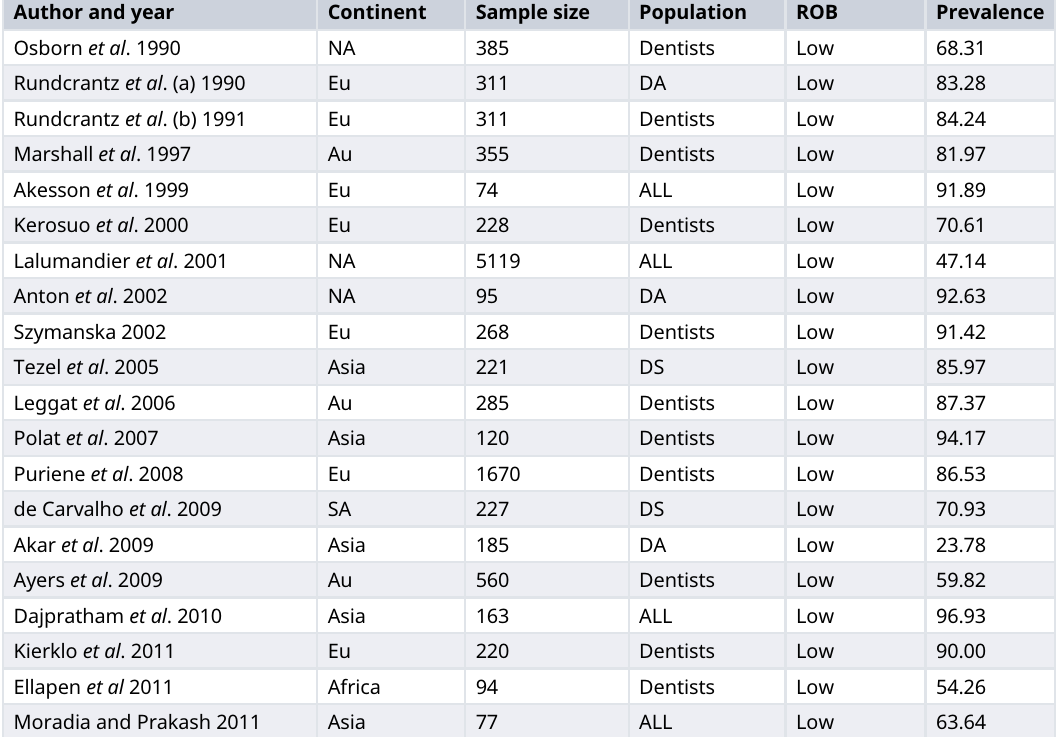
Table 1. Characteristics of the included studies in the